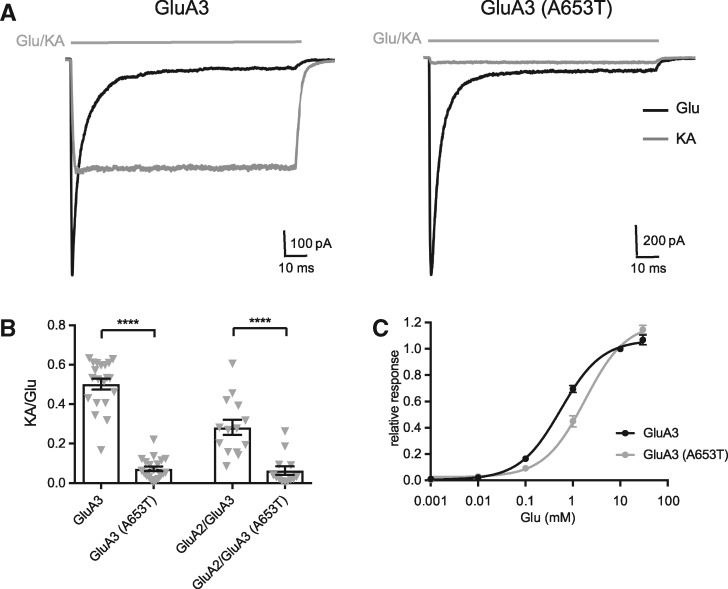
GluA3 with the A653T mutation displays reduced sensitivity to partial agonist kainate. (A) Example traces of current responses of GluA3 homomers or GluA3(A653T) homomers; outside-out patches from HEK293T cells stably expressing γ-2, voltage-clamped at -60 mV) to 10 mM l-glutamate (black) and 500 μM kainate (grey). (B) Summary graph for recordings shown in (A). The ratio of peak responses to kainate and glutamate (KA/Glu) was 50 ± 7% (n = 20) and 7 ± 1% (n = 20) for GluA3 and GluA3(A653T), respectively, and 28 ± 4% (n = 14) and 6 ± 2% (n = 13) for GluA2/GluA3 heteromers and GluA2/GluA3(A653T) heteromers, respectively. ****P < 0.0001 (unpaired t-test with Welch`s correction). (C) Concentration-response characteristics of GluA3 homomers or GluA3(A653T) homomers (in the presence of TARP gamma 2). Peak current responses to 100 ms application of 0.001–30 mM l-glutamate were fitted with a three-parameter dose-response curve (see Methods for details), yielding EC50 values of 0.53 mM and 1.65 mM for GluA3 homomers and GluA3(A653T) homomers, respectively.